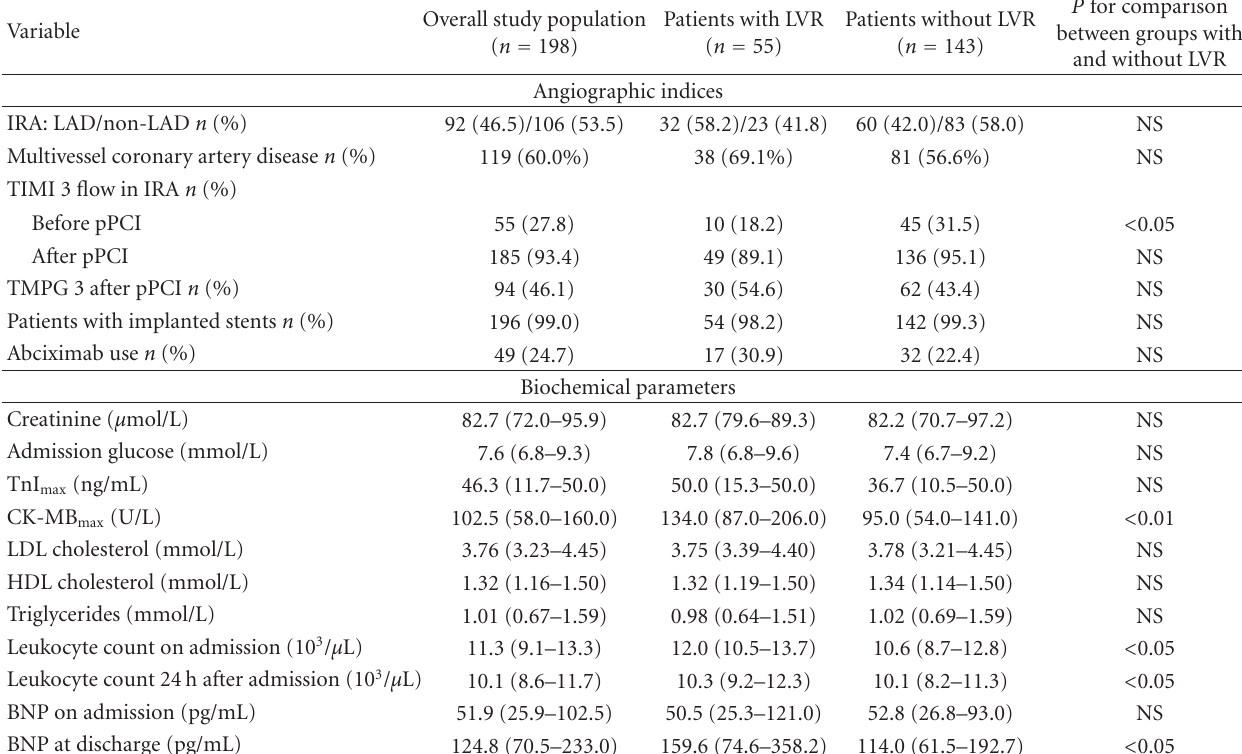
Table 2: Angiographic and biochemical characteristics of the study